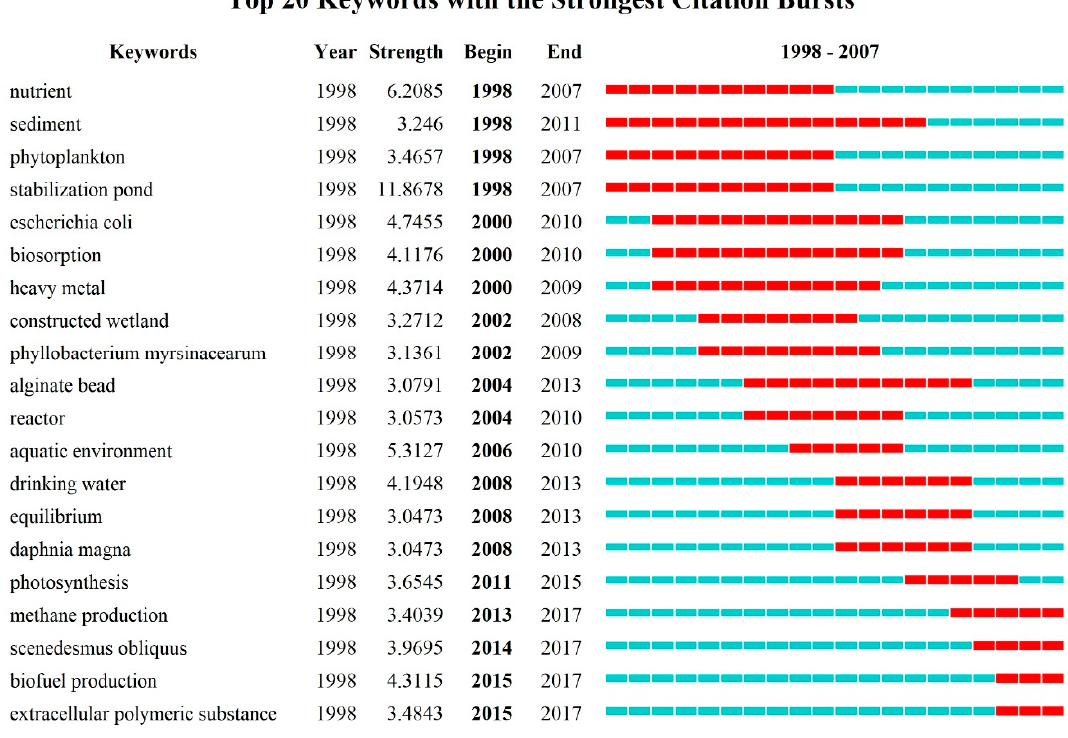
Figure 4. Top 20 keywords with the strongest citation bursts during 1998–2017.